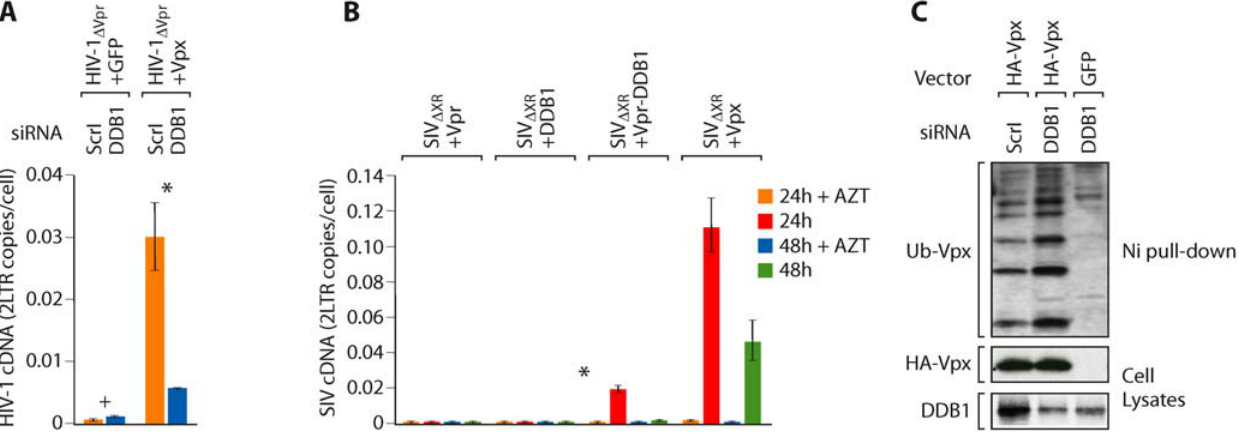
Figure 8. DDB1 is required for the ability of Vpx to counteract the restriction to macrophage infection by HIV-1. (A) SIV Vpx (or GFP as a control) was packaged into HIV-1 D Vpr virions as described in Figure 5 . Infectivity of those viruses for DDB1-depleted macrophages (DDB1 siRNA) or control macrophages (Scr I siRNA) were evaluated from levels of viral cDNA 24 h later ( + , p . 0.2; *, p , 0.002). (B) DDB1 packaging partially substitutes for Vpx. A Vpx/Vpr deletion mutant of SIV (SIV D XR ) was co-transfected with vectors expressing SIV Vpr, SIV Vpx, DDB1 or a Vpr-DDB1 fusion. Infectivity of the resulting viruses for macrophages was evaluated from levels of SIV cDNA at 24 and 48 h post infection (*, p , 0.005). (C) Impact of DDB1 silencing on Vpx ubiquitylation. 293T cells were cotransfected with DDB1 or scrambled siRNAs and with HIS-ubiquitin and HA-Vpx or IRES-GFP expression plasmids as outlined in Figure 3. Ubiquitin-conjugated proteins were nickel purified and immunoblotted for Vpx (HA). Cell lysates were directly blotted for Vpx and DDB1 proteins (lower two panels).